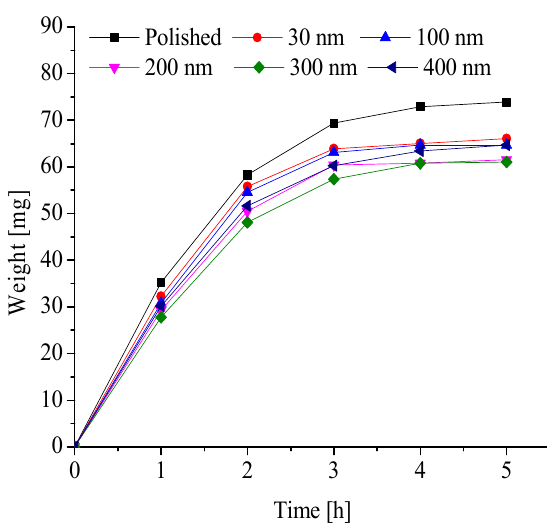
Figure 18. Variations of frost weight with different nanoporous diameters at T = − 15 °C, φ = 90%.